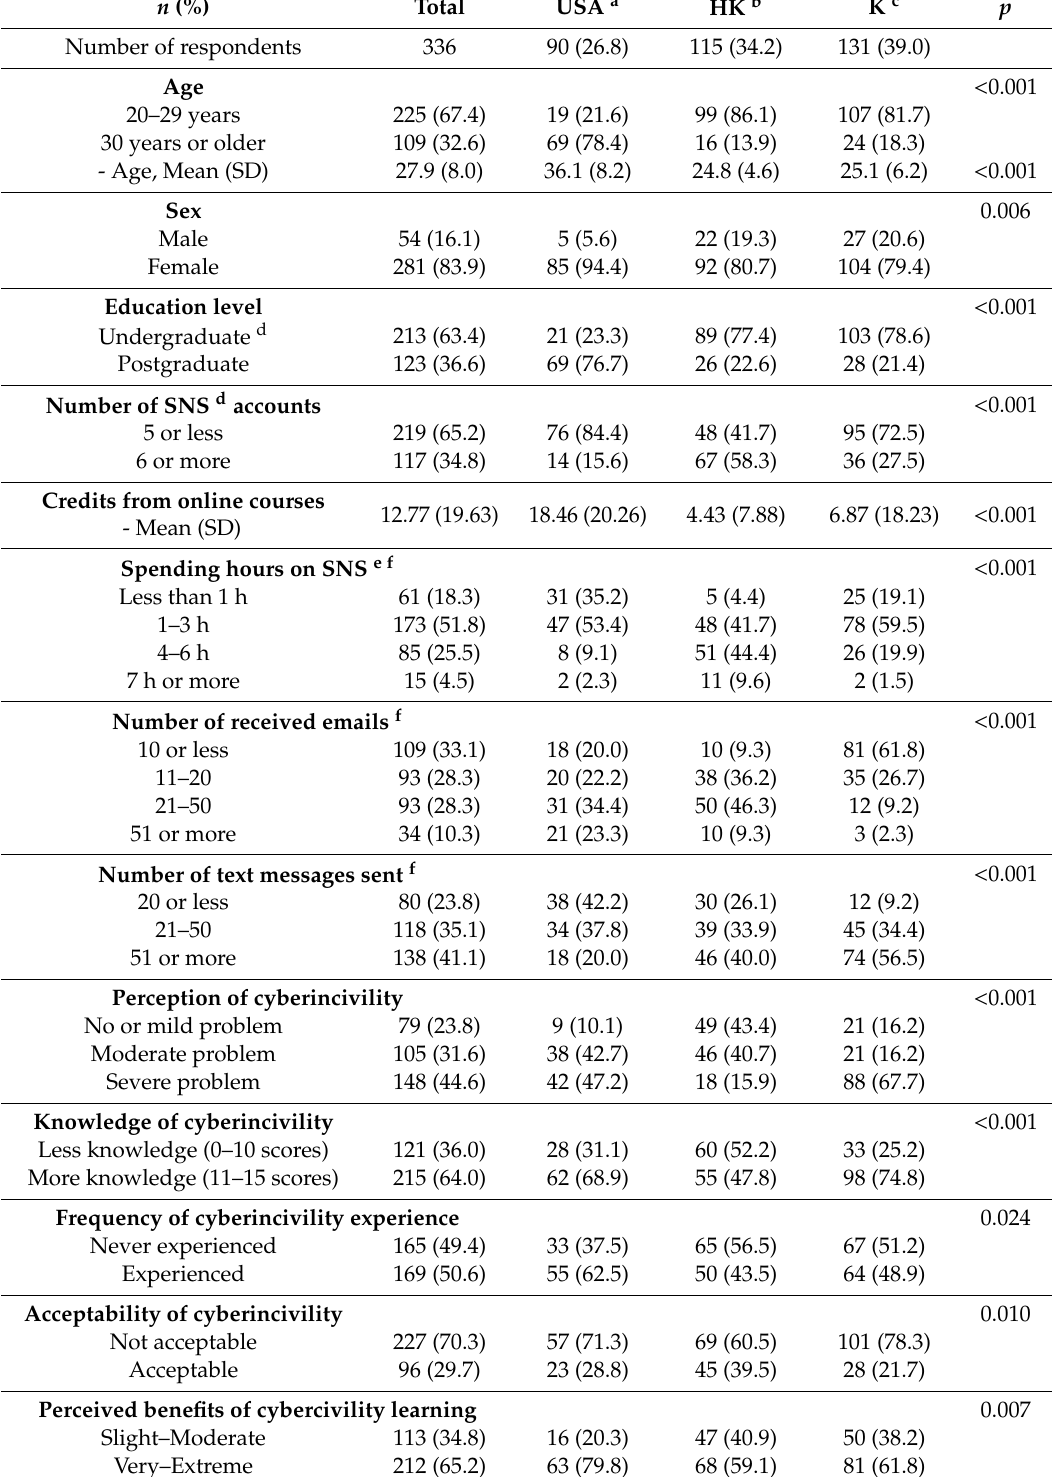
Table 1. Demographics of respondents, according to three